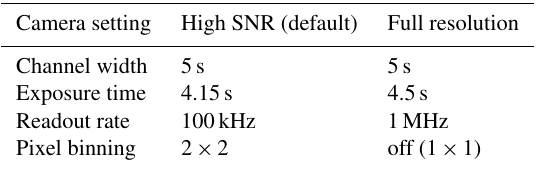
Table 3. Recommended settings for a Princeton Instruments ProEM512 camera employed in a Freiberg Instruments lexsyg re- search